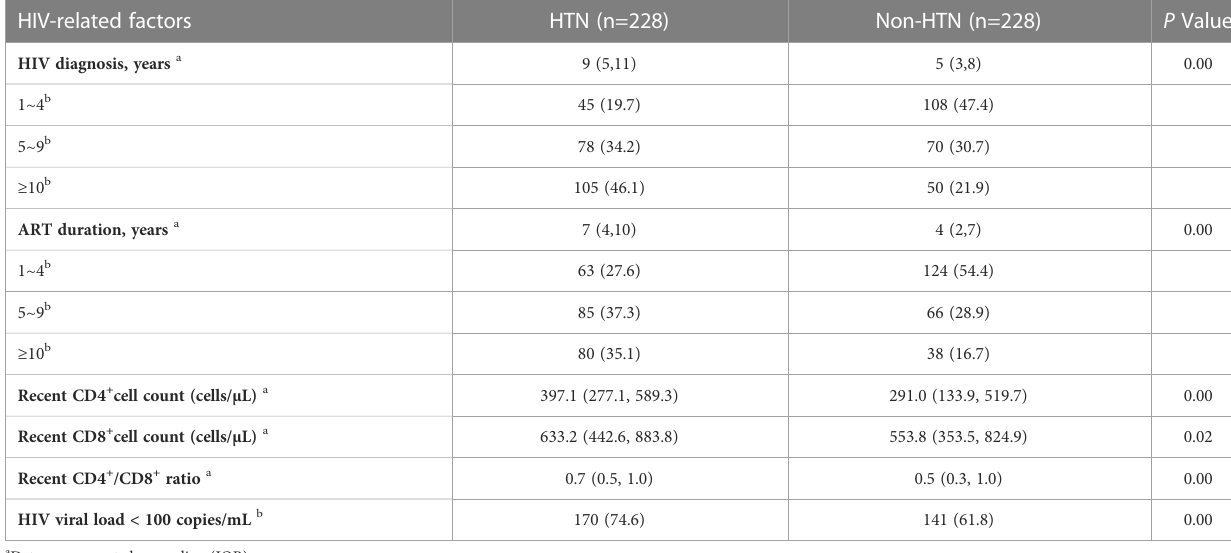
TABLE 2 HIV-related factors of Patients in Both